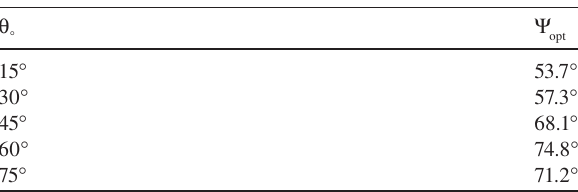
Effect of subtended angle on the optimum fi ber